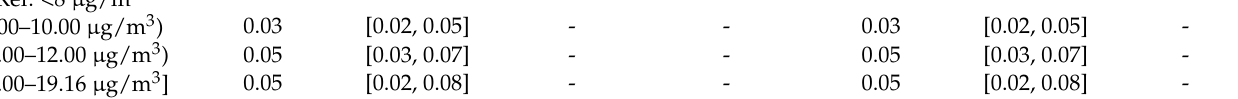
Panel B: Direct and indirect associations of the postnatal PM 2.5